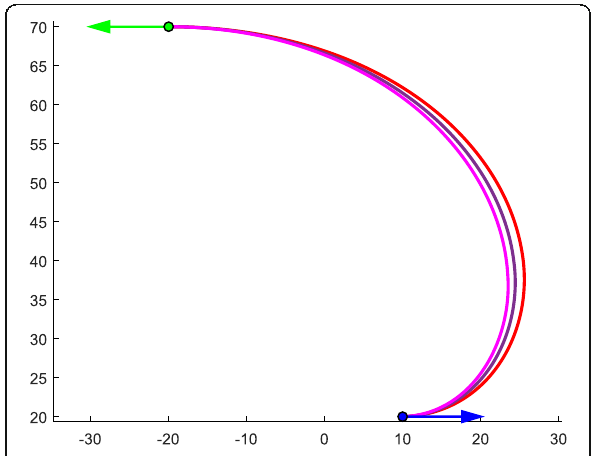
Fig. 9 Multiple solutions of typical curves with different degrees under the same conditions